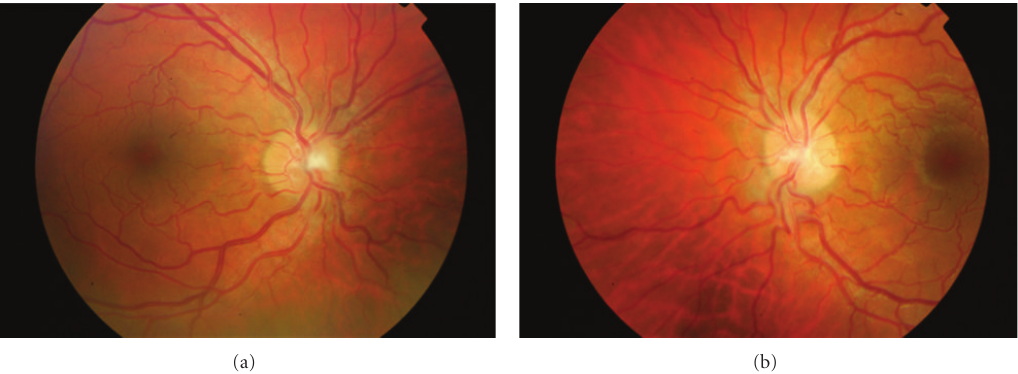
Figure 2: Retinal photographs of the right (a) and left (b) eyes 1 week after the initial visual symptoms. In the right optic disc, the limits are blurred more prominently in the superior and inferior poles. In the left eye optic disc, contour is almost